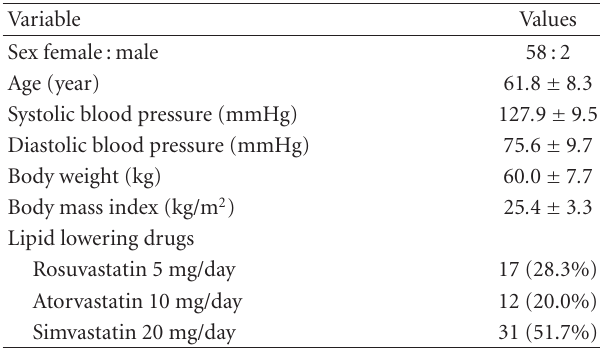
Table 1: Baseline clinical characteristics of study